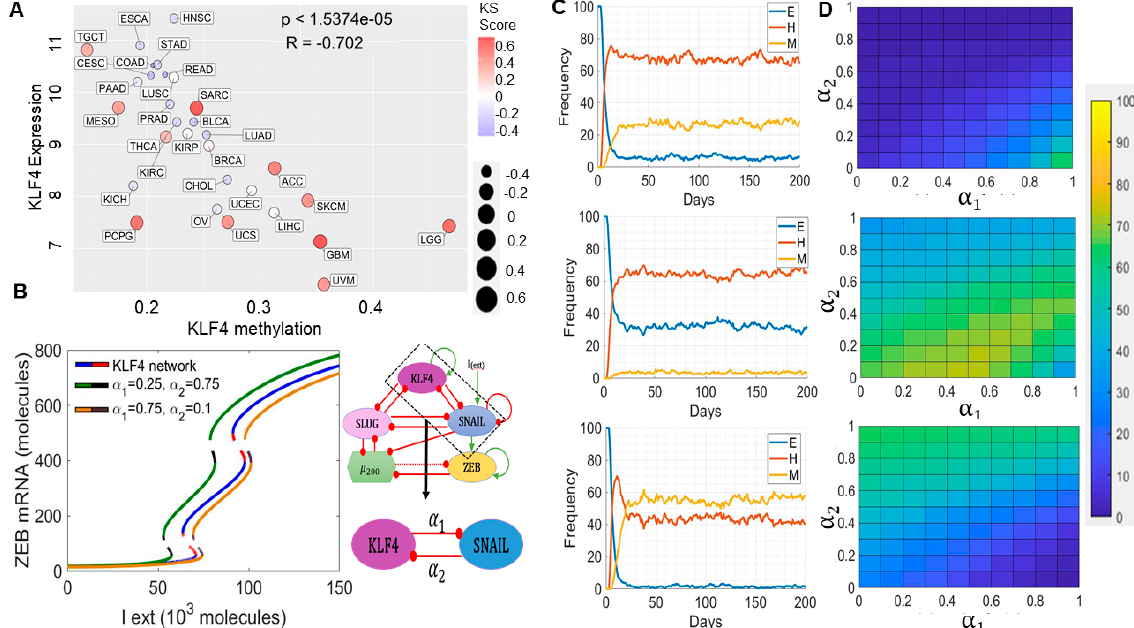
Figure 4. Epigenetic modulations involving KLF4 can alter the population dynamics of EMT states. ( A ) Scatter plot for KLF4 expression and its methylation status in TCGA types. ( B ) Bifurcation diagrams indicating the ZEB mRNA levels for increasing the EMT-inducing external signal (I_ext) levels for the coupled EMT–KLF4 circuit (solid blue and dotted red curve), for the circuit with higher α 1 and lower α 2 values (solid yellow and dotted brown curve), and for the circuit with lower α 1 and higher α 2 values (solid green and dotted black curve). ( C ) Stochastic simulation of the KLF4–EMT network for varied values of α 1 and α 2 . ( Top ) α 1 = α 2 = 0, ( middle ) α 1 = 0.75 and α 2 = 0.1, and ( bottom ) α 1 = 0.25 and α 2 = 0.75. ( D ) Population distribution of E ( top ), hybrid E/M ( middle ), and M ( bottom ) cells for varying values of α 1 and α 2 . In panel A; 1.5374e-05 means 1.5374 × 10 − 5 .